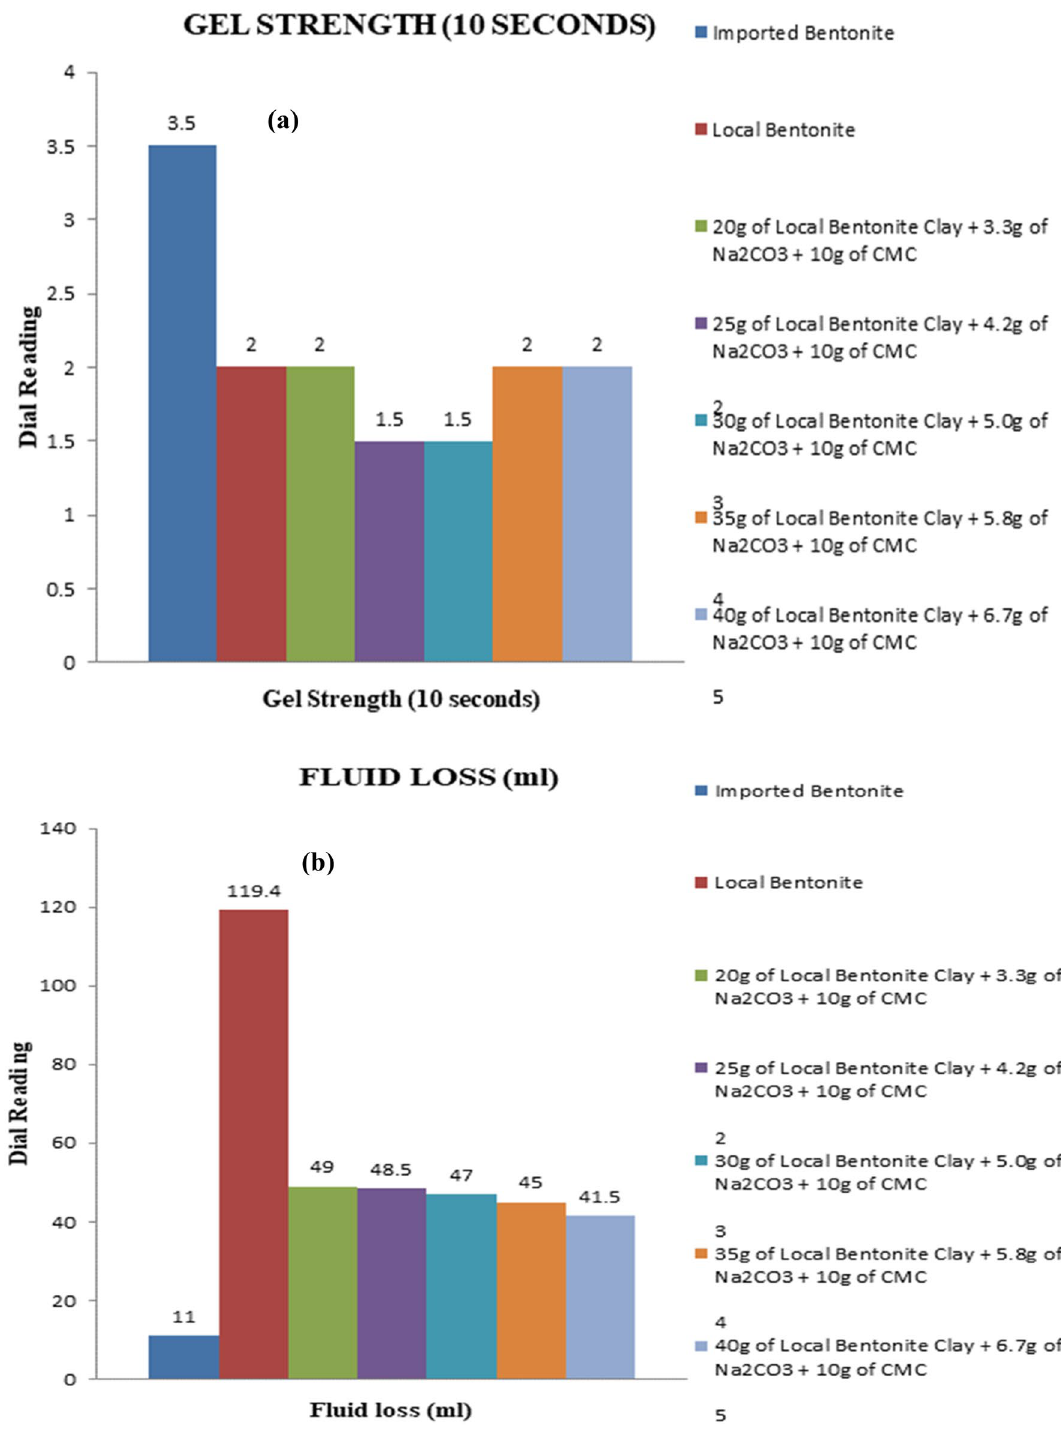
Fig. 12 Histogram showing the gel strength at 10 min ( a ) and the fluid loss ( b ) of